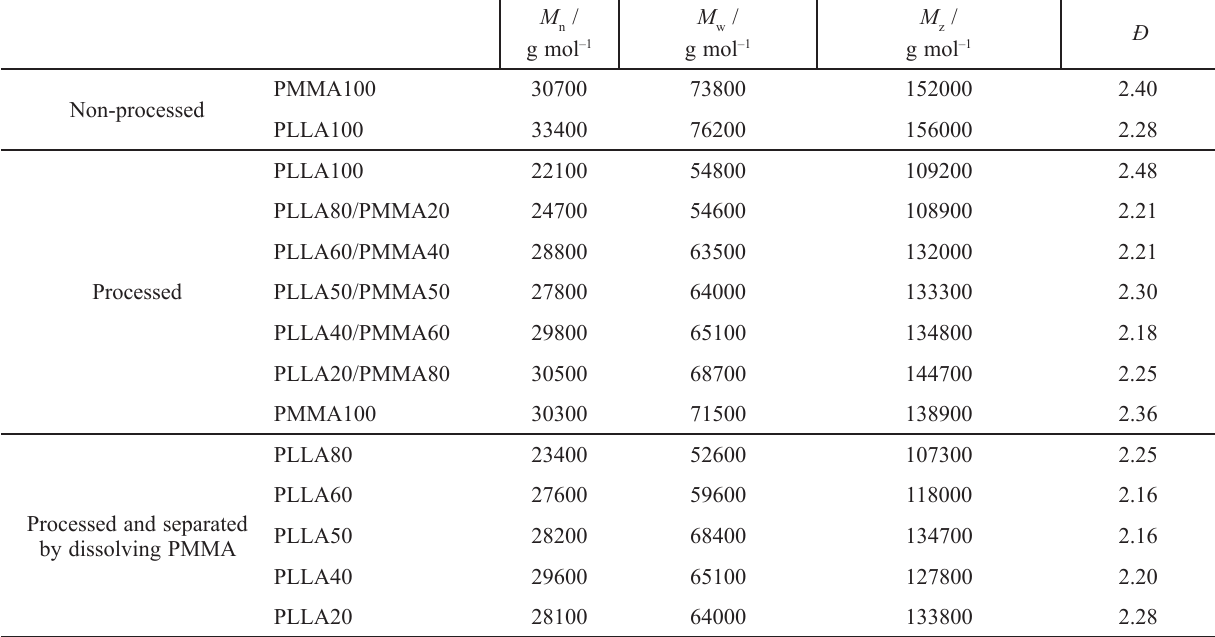
Table 1 – Number (M ), weight (M ), and z-molar mass averages (M n w acid) – PLLA, poly(methyl methacrylate) – PMMA, and their